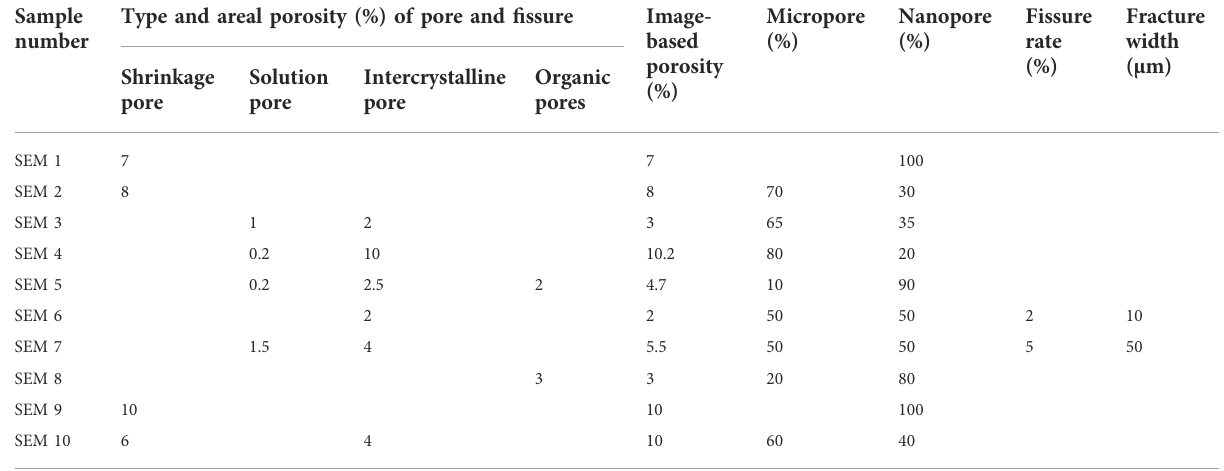
TABLE 2 Characteristics of pore and fi ssure in SEM. Sample